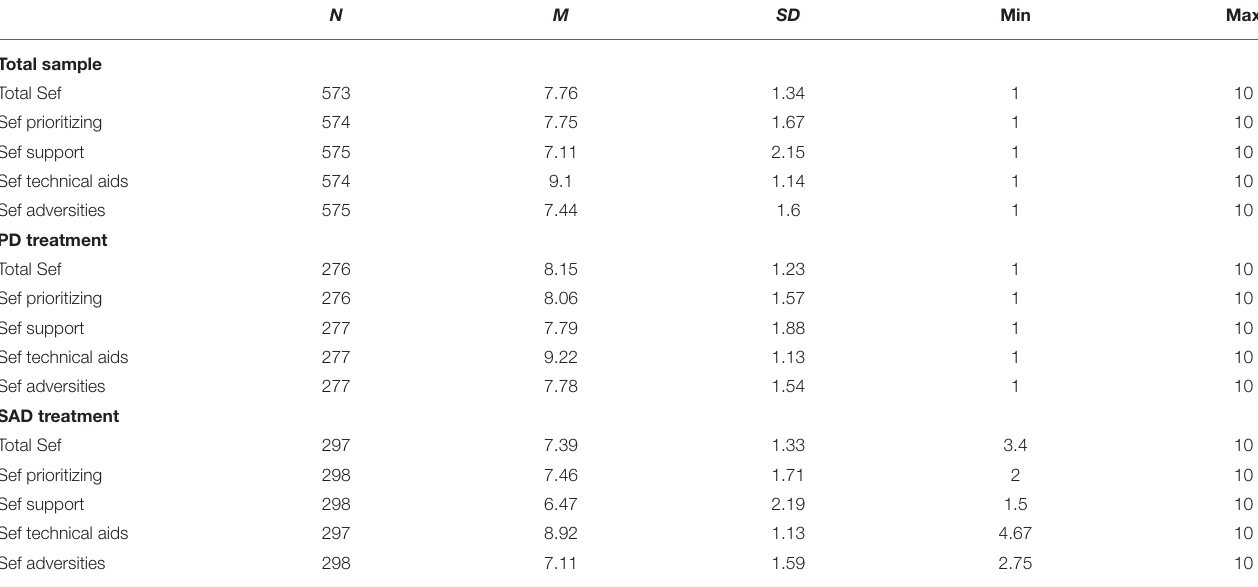
TABLE 2 | Descriptive data of the self-efficacy scale. N M